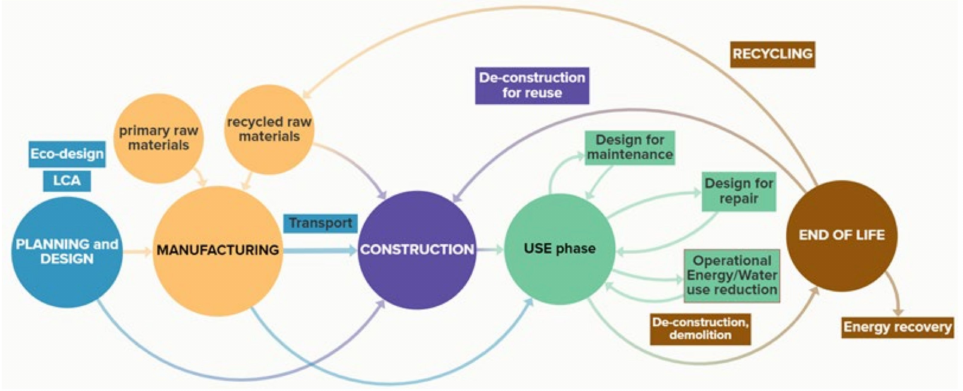
Figure 1. CE framework for buildings. Own elaboration based on Fundaci ó n Conama, 2018